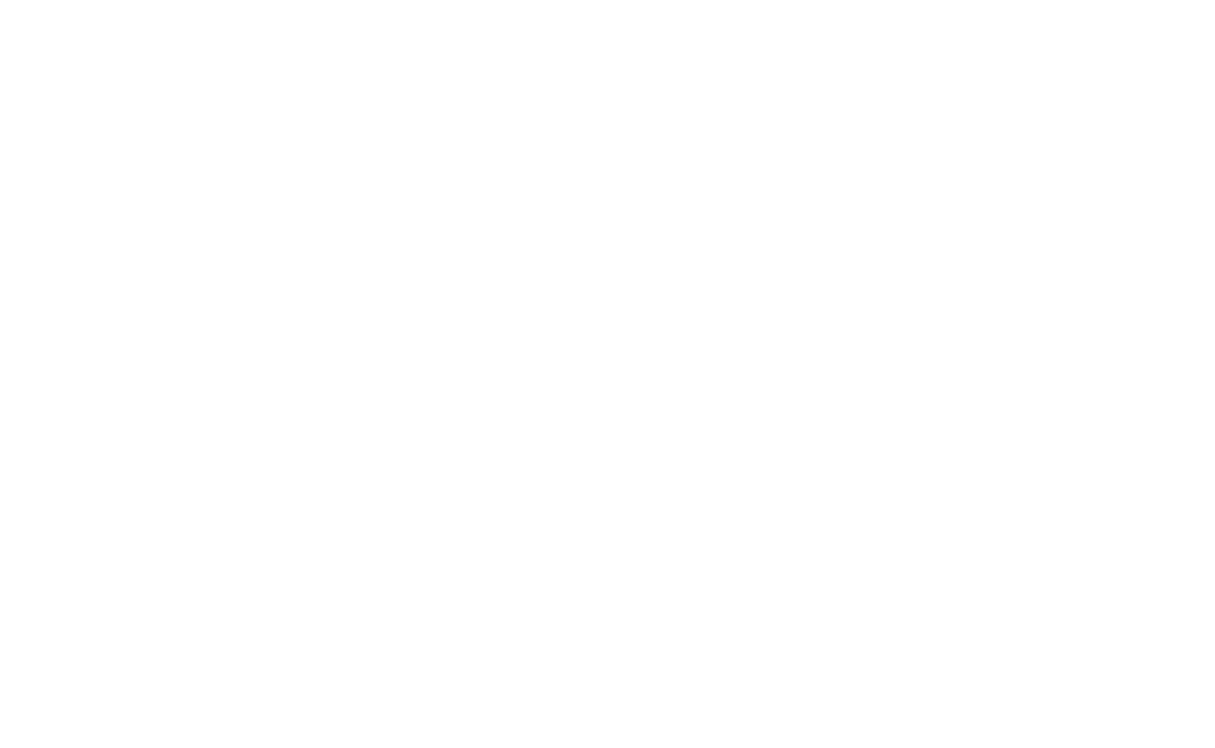
FIGURE 6 | Trilineage differentiation. (A) Positive trilineage potency for adipogenesis (Oil Red O), osteogenesis (Alizarin Red S), and chondrogenesis (Toluidine blue) for treated (ESWT + ) and untreated (ESWT–) equine CB-MSC. (B) Quantification of intracellular lipid droplets by relative fluorescent units for treated (ESWT + ) and untreated (ESWT–) equine CB-MSC. Results are shown as mean and CI 95% ( p = 0.0002). Values with different letters are statistically different ( p = 0.002). (C) Alkaline phosphatase activity measured in relative fluorescent units in treated (ESWT + ) and untreated (ESWT–) equine CB-MSC. Differences were found at time 0 ( p = 0.0045) and 5mins ( p =